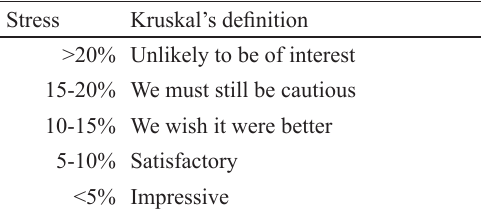
Table 2. Evaluation of Kruskal’s stress . Stress